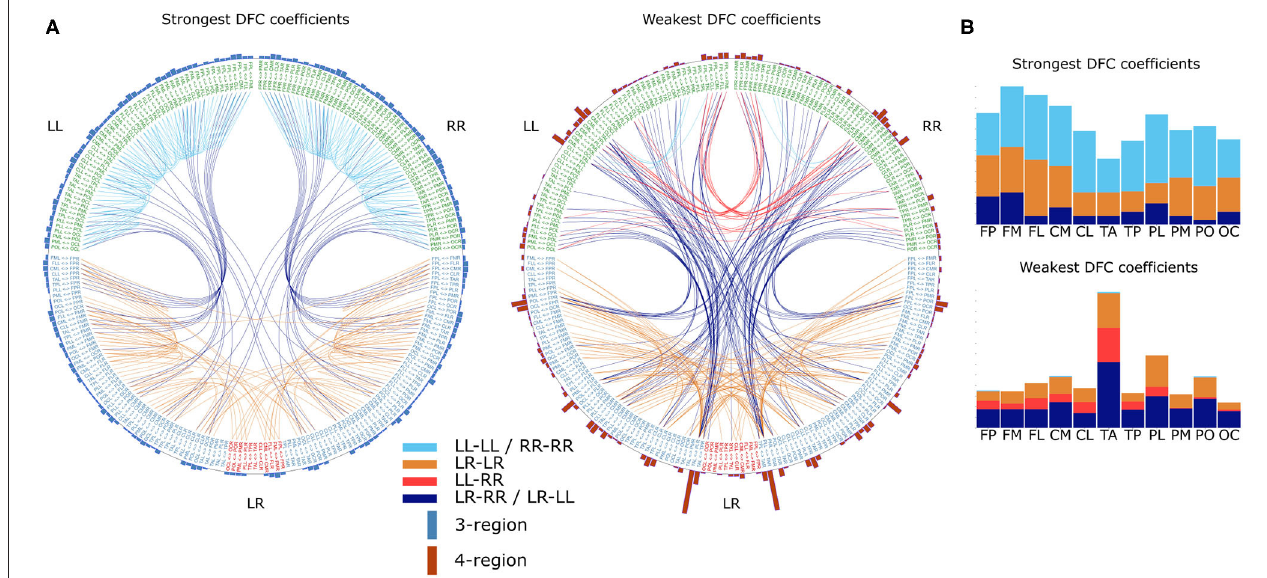
FIGURE 6 | Common DFC profile characteristics in the α 1 frequency band. (A) Strongest DFC coefficients (left) and weakest DFC coefficients (right) in the group averaged DFC profile. For visualization DFC coefficients in the top 99 and bottom 1 percentile are shown. Text on the circle represent all 231 functional connections and we made a distinction between unilateral (LL and RR) and bilateral (LR) connections. Except for connections between cross-hemisphere homologs (LR), connections are ordered such that the left and right half are mirror images. Each line represents a DFC coefficient and its color distinguishes between the 4 lateralization based categories. Additionally, on the outer circle we used a bar for each connection to summarize in how many DFC coefficients it was involved. Furthermore, each bar is divided in a blue and a red part indicating the number of 3-region and 4-region DFC coefficients, respectively. (B) In the barplots the same data is plotted as the incidence of scalp regions in the set of DFC coefficients, averaged over both hemispheres. L, left hemisphere; R, right hemisphere; FP, fronto-polar; FM, frontal-mid; FL, frontal lateral; CM, central mid; CL, central lateral; TA, temporal anterior; TP, temporal posterior; PL, parietal lateral; PM, parietal mid; PO, parietal occipital; OC, occipital. (c) Differences between the several DFC coefficient categories based on the average DFC profile of 7 all healthy individuals. Boxplots represent median (stripe), 25th and 75th percentiles (box), 1.5 times the interquartile range (whiskers), and outliers (crosses). Box colors and legend indicate DFC coefficient